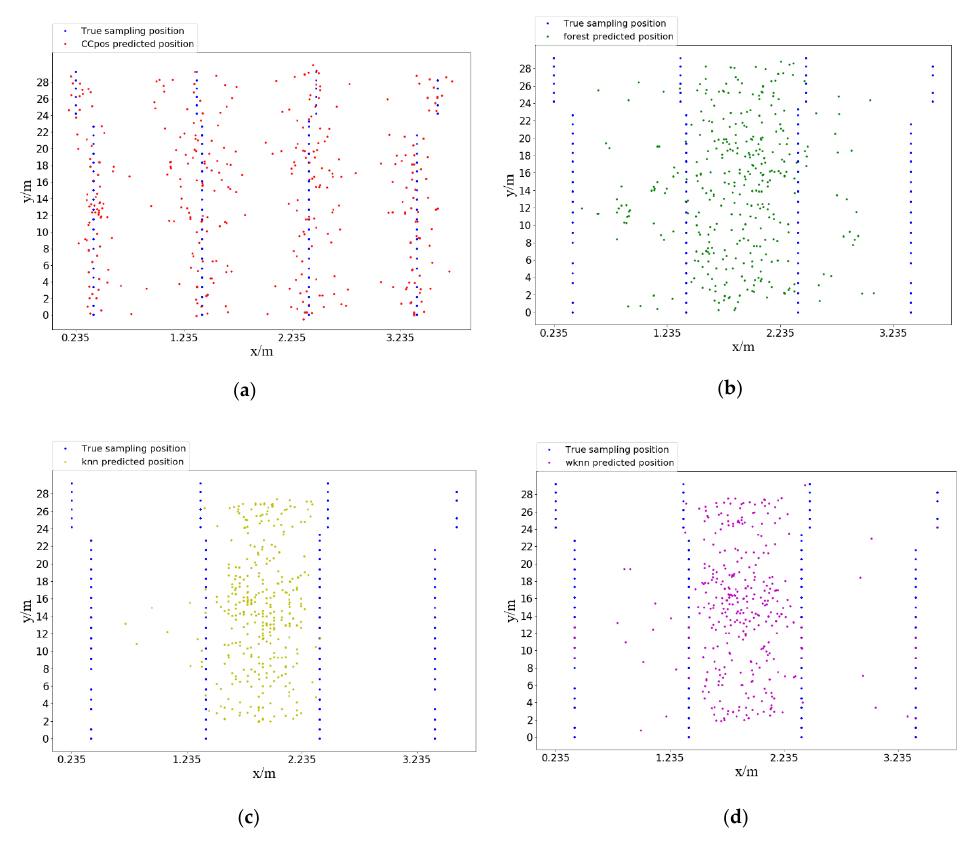
Figure 8. Comparison of true and predicted positions. ( a ) True position vs. CCpos predicted position; ( b ) true position vs. Random Forest predicted position. ( c ) true position vs. KNN algorithm predicted position; ( d ) true position vs. WKNN algorithm predicted